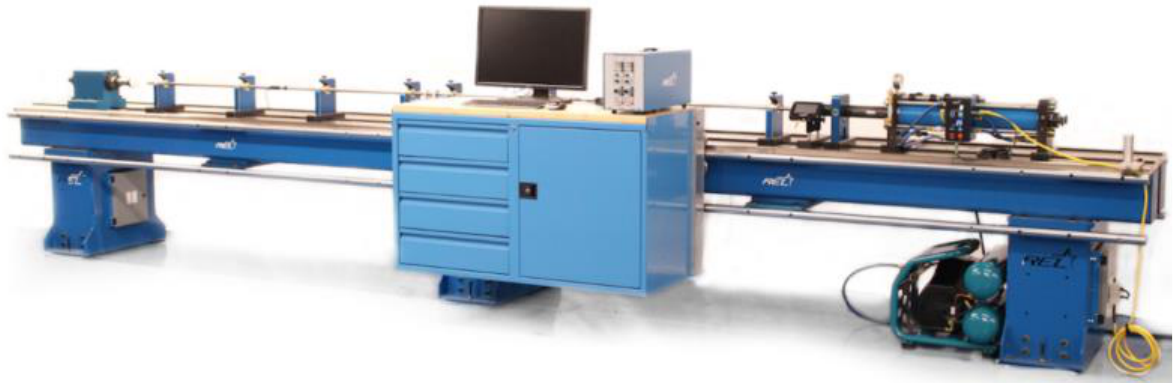
Figure 1. SHPB apparatus.